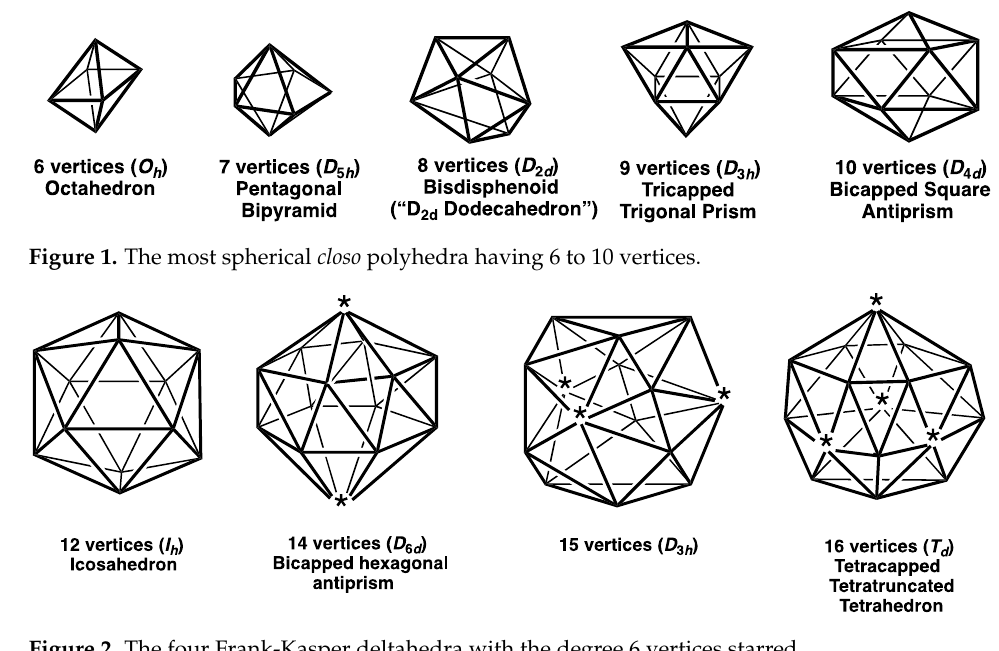
Figure 1. The most spherical closo polyhedra having 6 to 10 vertices.